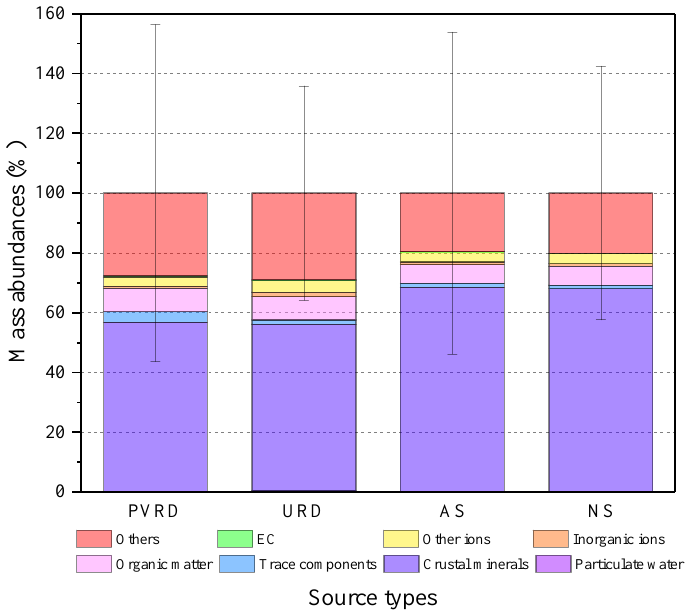
Figure 3. Major components for geological sources of urban paved road dust (PVRD), urban resuspended dust (URD), agricultural soil (AS) and natural soil (NS) from southwestern regions of China. Error bars represent the total propagated error calculated from the standard deviation of samples within each source type for each chemical component; the definition of each component can be found under the heading “ Contributions of the major components ”.